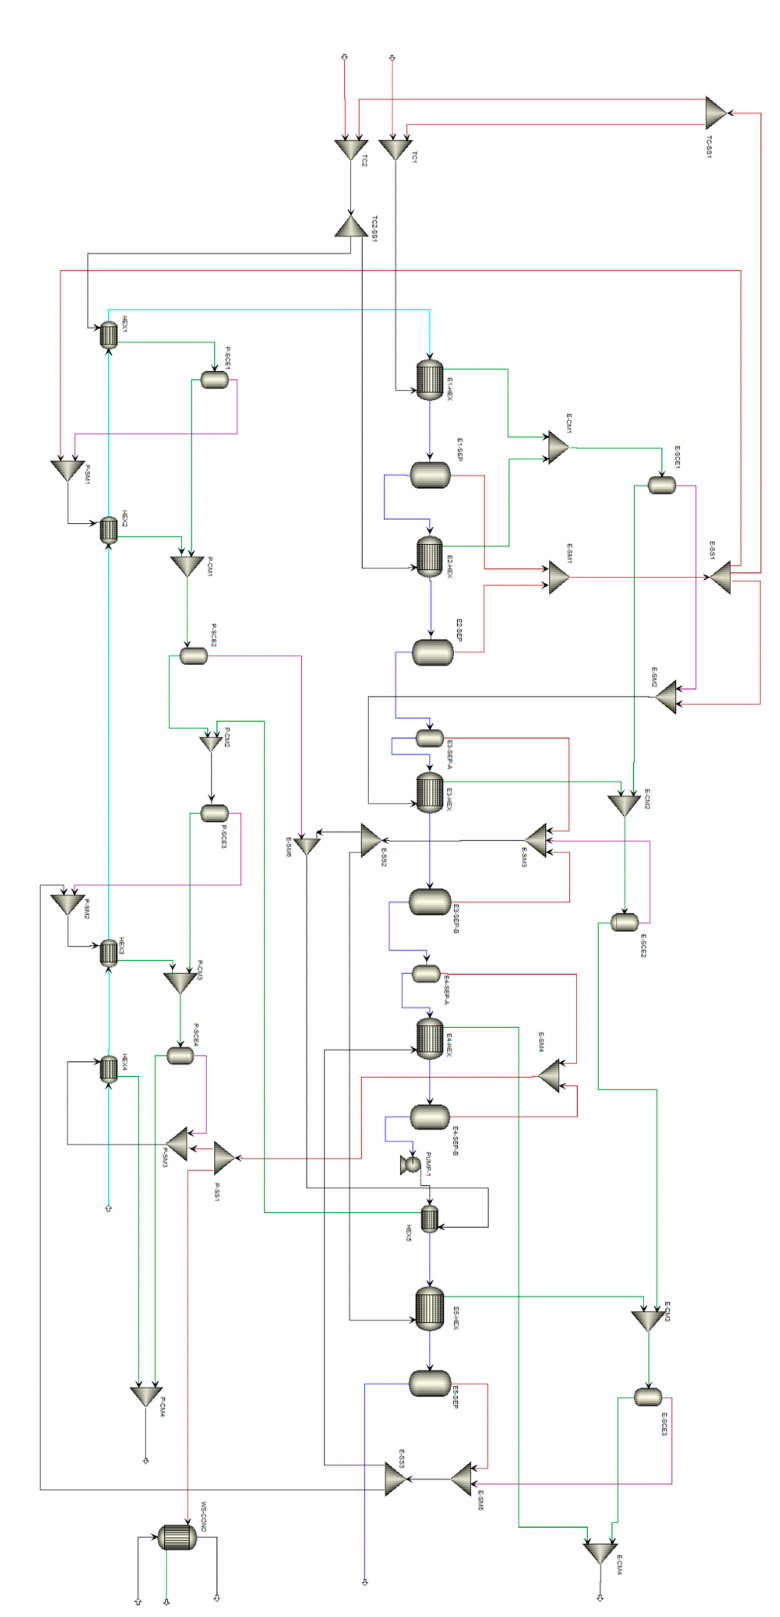
Figure 3. Aspen Plus process flowsheet of milk preheating and concentration (color specification of streams compatible with Figure